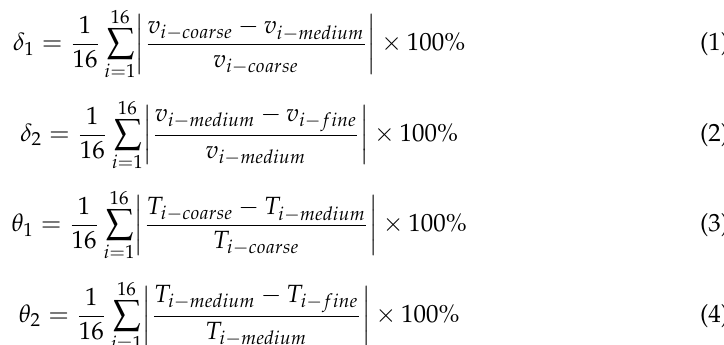
Figure 2. The semi-enclosed stadium main dimensions. 2.2. Details of CFD Mesh The accuracy and time cost of CFD simulations are substantially influenced by the quality of the computational mesh [38]. For CFD models which simulate the indoor and outdoor flow simultaneously in the same computational domain, the significant geomet- rical length scale differences between the urban environment and the stadium structure will lead to a large domain with high-resolution mesh [13]. Thus, local control over the entire mesh was employed to enhance the quality of the mesh. A mesh with 9.3 mil tetra- hedron elements was generated and used for the analysis. The cell sizes of the stadium,